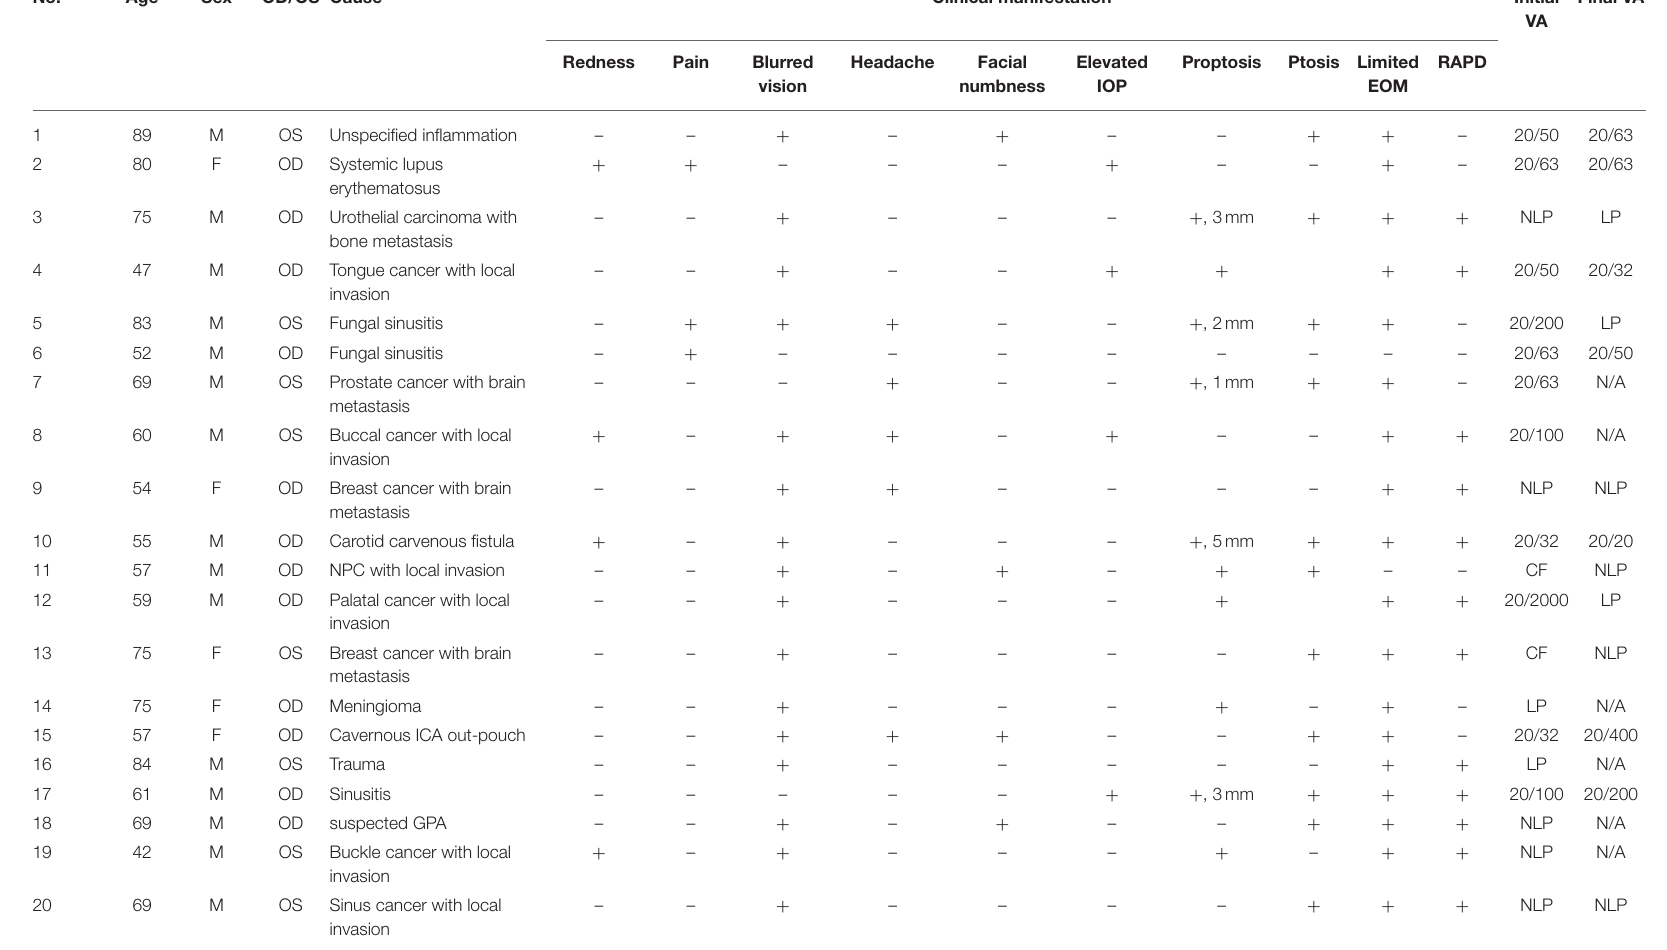
TABLE 1 | Basic information of each patient with orbital apex syndrome.